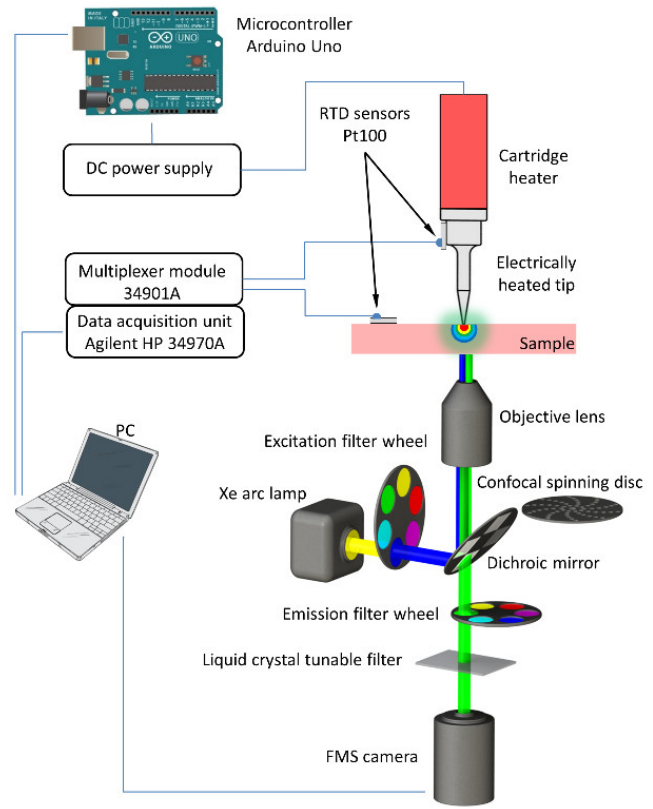
Figure 1. Scheme of the experimental setup. A confocal fluorescence microscopy system was used to evaluate the thermal properties of the temperature-sensitive glass-ceramic.